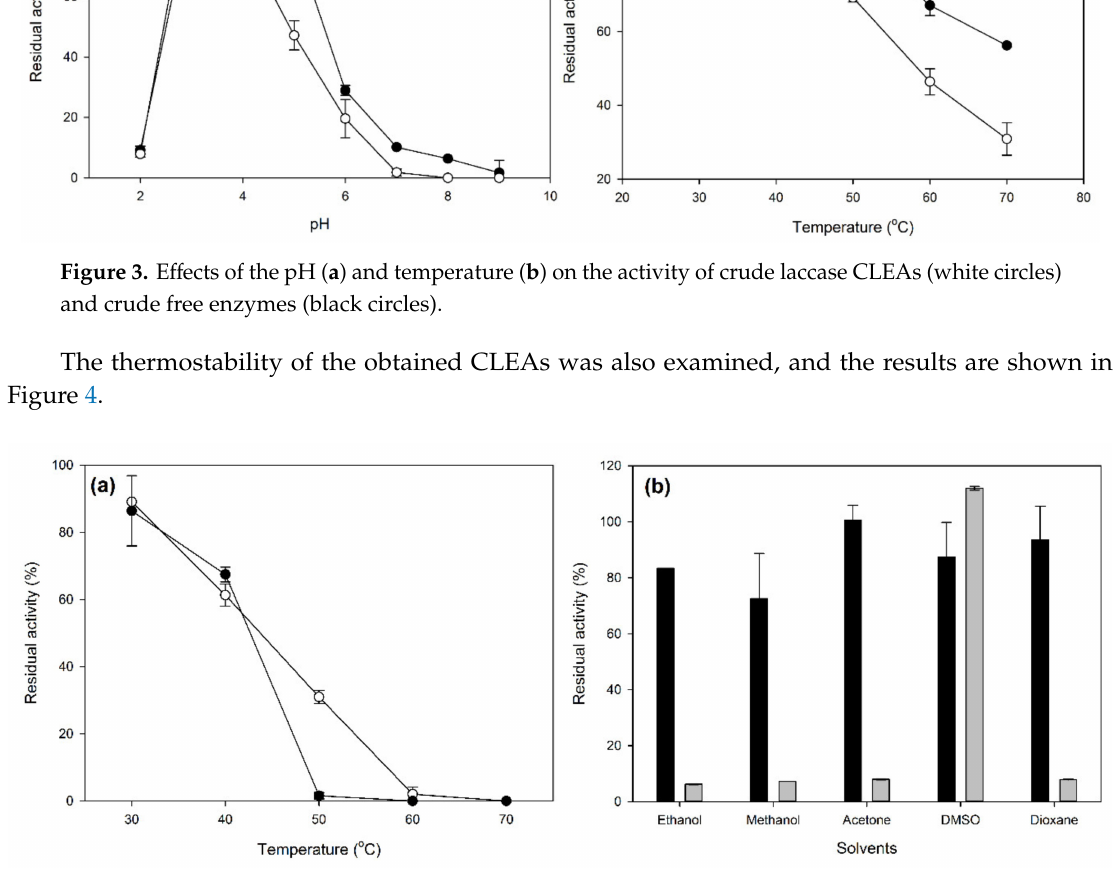
Figure 4. E ff ects of temperature ( a ) and organic solvents ( b ) on the stability of crude laccase-CLEAs. The residual laccase activity was measured after 24-h incubation in the indicated conditions. The calculation of residual activity was performed against suitable controls. White circles: CLEAs, black circles: crude free enzyme, black bars: CLEAs, and light grey bars: crude free